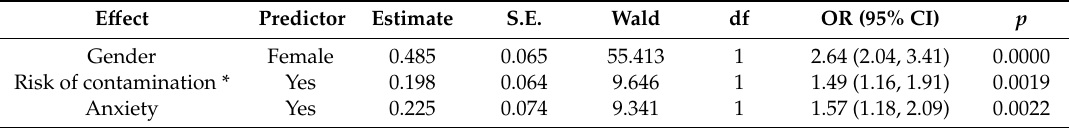
Table 13. Prediction of sleep bruxism (SB) in Poland.